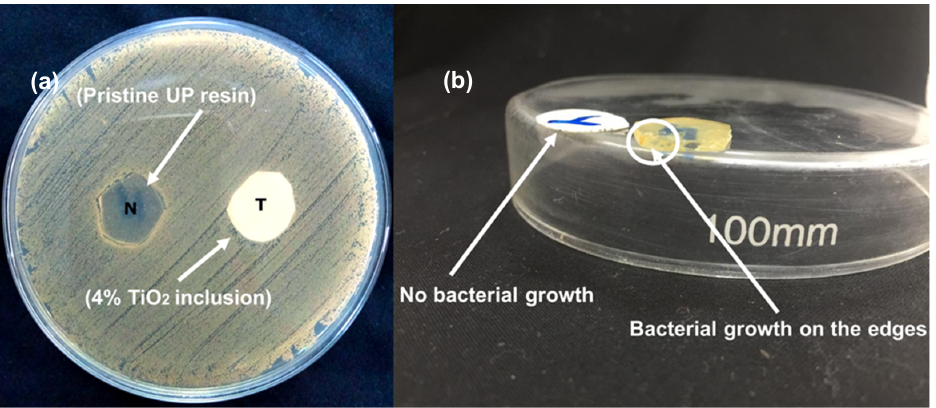
Figure 8. ( a ) Comparative antibacterial efficacy, bacterial growth is seen around the pristine UP resin sample and edges, ( b ) 4% TiO 2 -UP has showed no growth on surface.